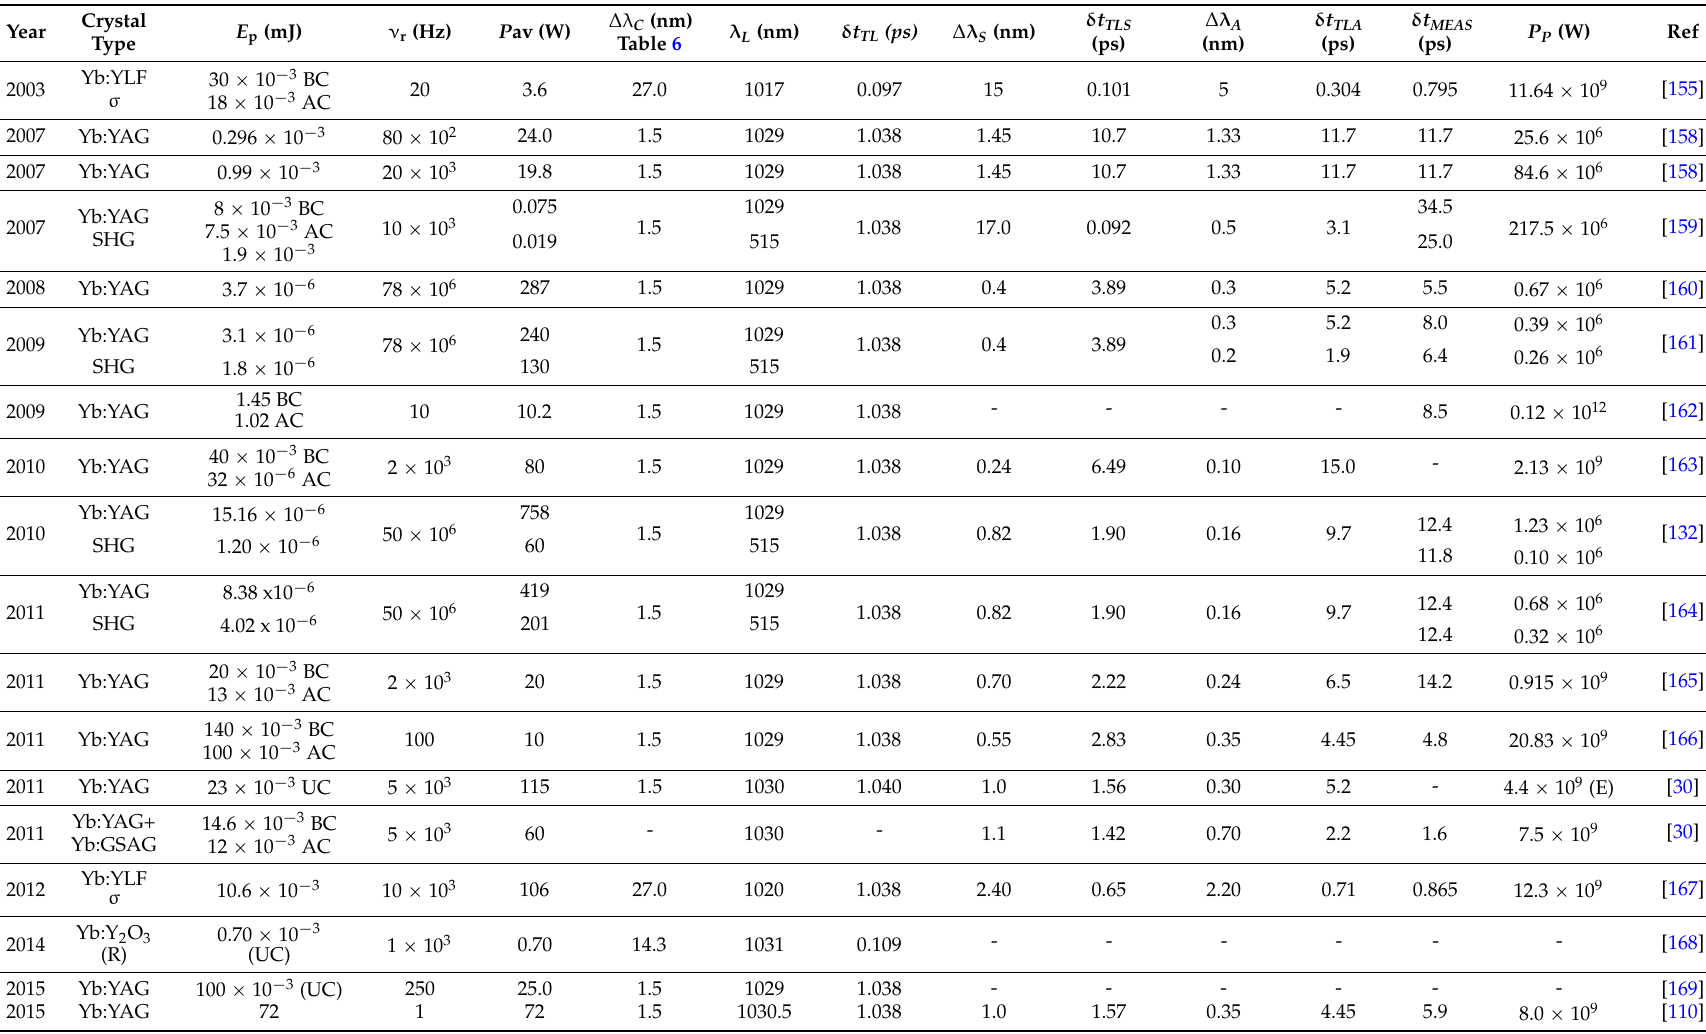
Table 10. Reported Yb:YAG, Yb:YLF, and Yb:Y 2 O 3 Cryogenic Picosecond and Femtosecond Demonstrations From